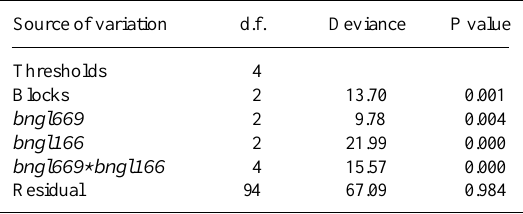
Table III - Analysis of deviances for marker genotypes at loci bngl669 and bngl166. Source of variation